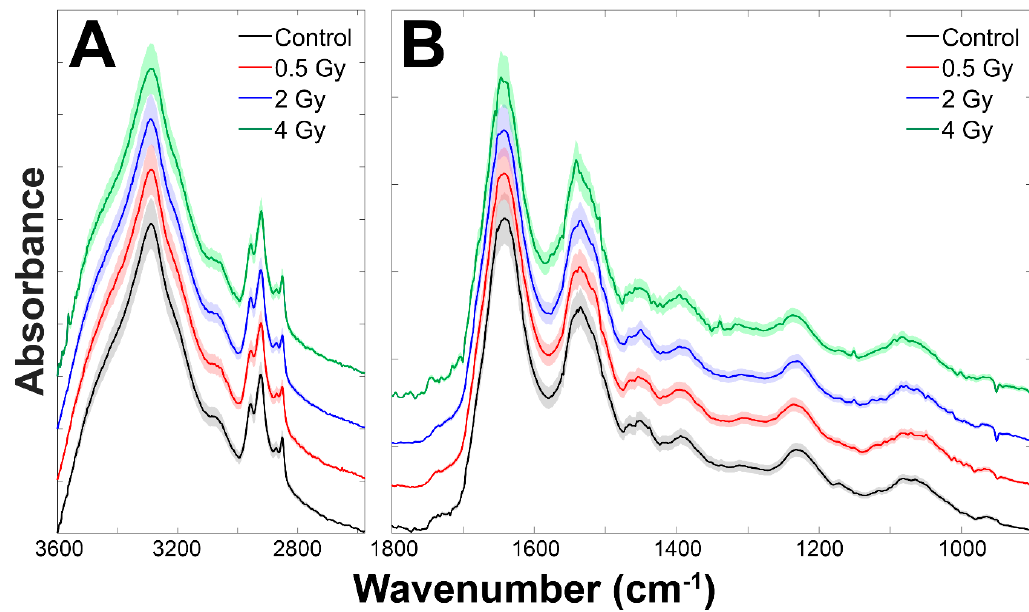
Figure 1. Comparison of average spectra for control and proton irradiated MCF-10A cells ( A ) in the high wavenumber region (3600–2600 cm − 1 ) and ( B ) in the fingerprint region (1800–900 cm − 1 ) at different proton doses (0.5, 2, 4 Gy); data are presented as Mean ± SD. For each dose three slides were examined. On each slide, at least three regions were investigated, and three spectra were obtained for each position. A total number of at least 27 spectra was obtained.